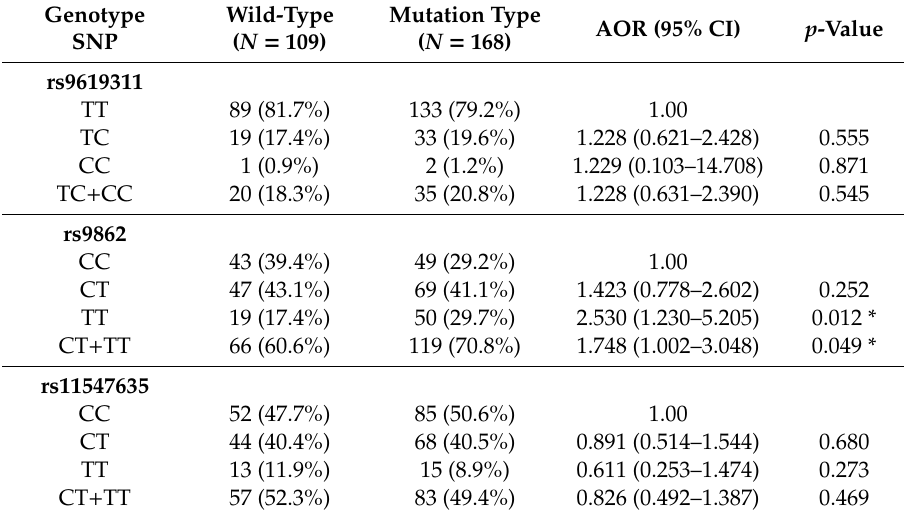
Table 2. Distribution frequencies of tissue inhibitor of metalloproteinases (TIMP)-3 genotypes of patients with lung adenocarcinoma and multiple logistic regression analysis of epidermal growth factor receptor (EGFR) mutation